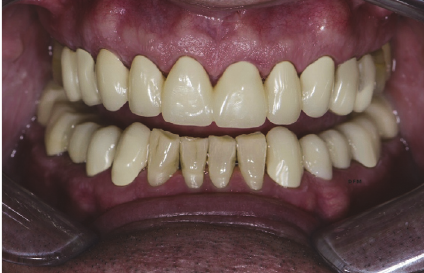
Figure5:Clinicaltestandevaluationofthedefinitivecrownsdesign through the 3D printed crowns: analysis of the finishing lines, interproximal areas, occlusal contacts, and aesthetic result.